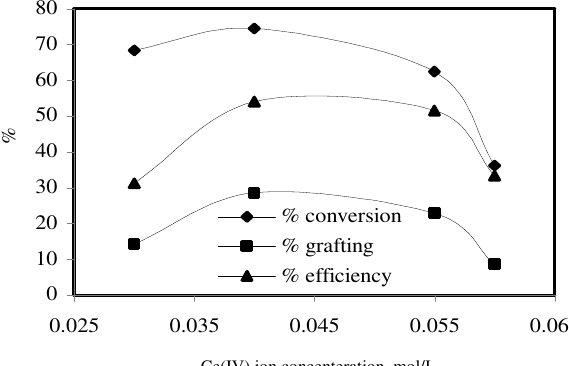
Figure 4 . Influence of concentration of the ceric ion on the grafting of not bleached fibres